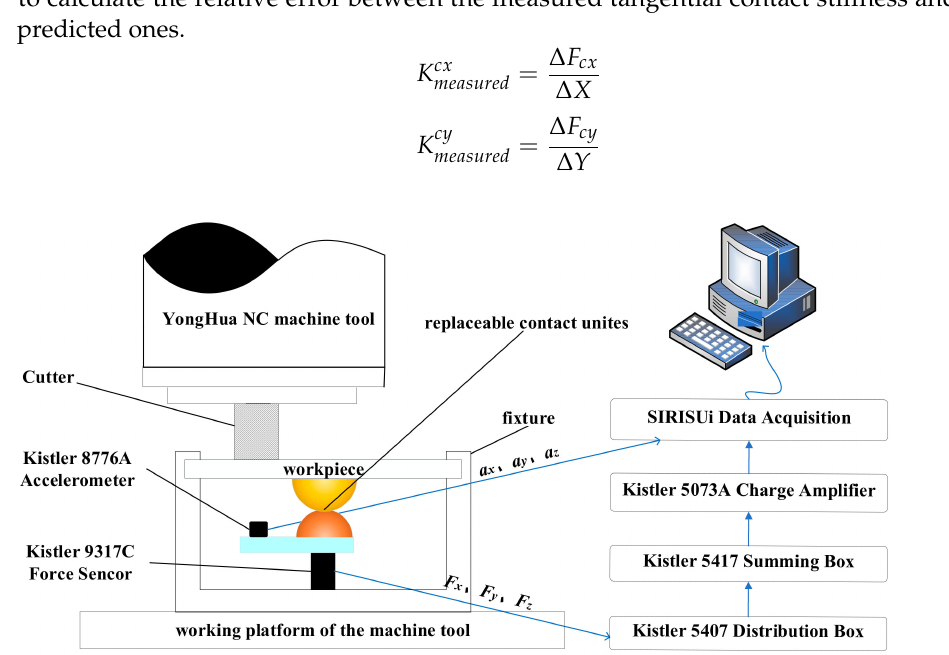
Figure 3. The data collection and transmission process of the modified tangential stiffness model validation